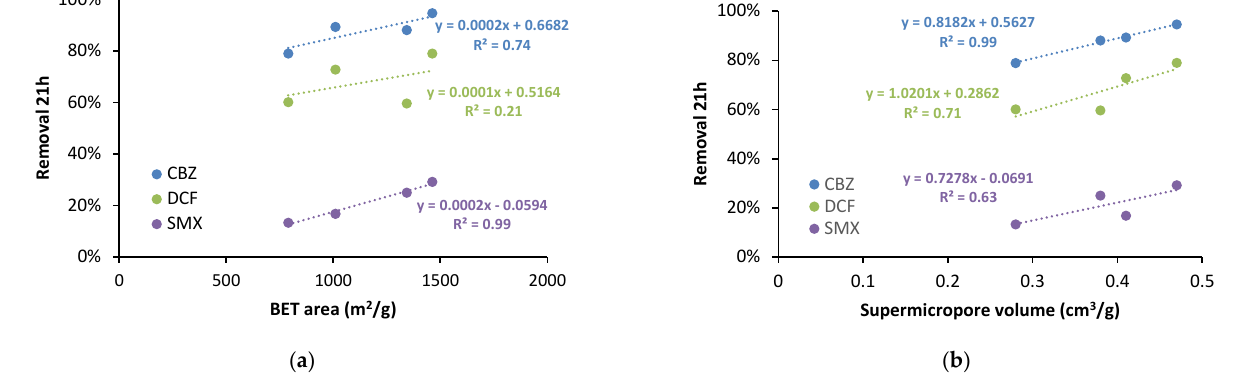
Figure 1. Univariate relationship between removal efficiencies of target PhCs and PACs’ textural parameters: apparent surface (BET) area ( a ) and supermicropore volume ( b ) (assays performed in SE6).